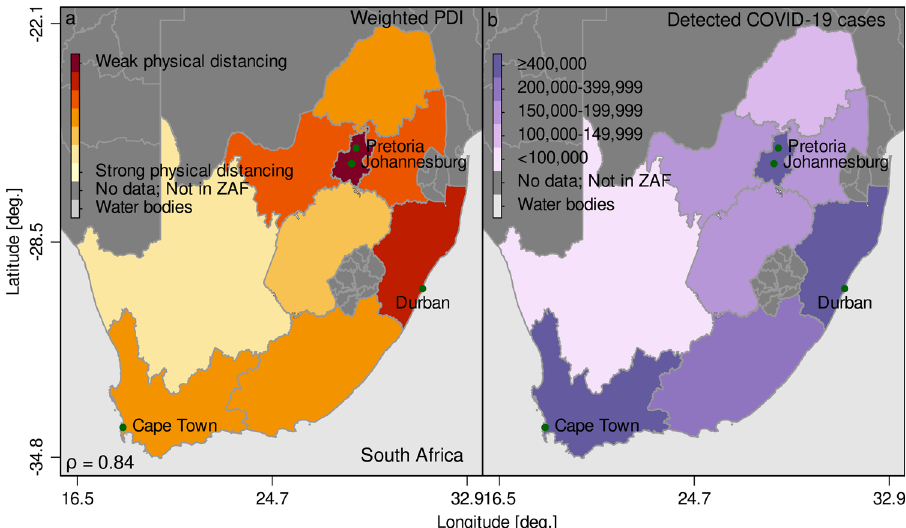
Fig. 3 Comparison of the PDI and detected COVID-19 cases in South Africa. Population weighted PDI ( a ), and observed cumulative caseload ( b ) at the regional level for South Africa. Note that we used the latest available information on the aggregated regional caseload. Source: Information on the regional caseload for South Africa is publicly available data which we are happy to share upon request and DHS; calculations by the